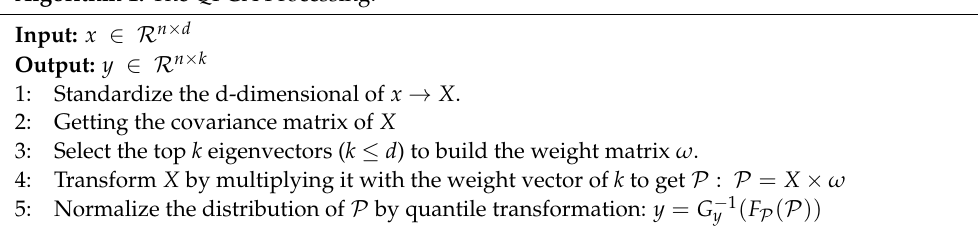
Algorithm 1. The QPCA